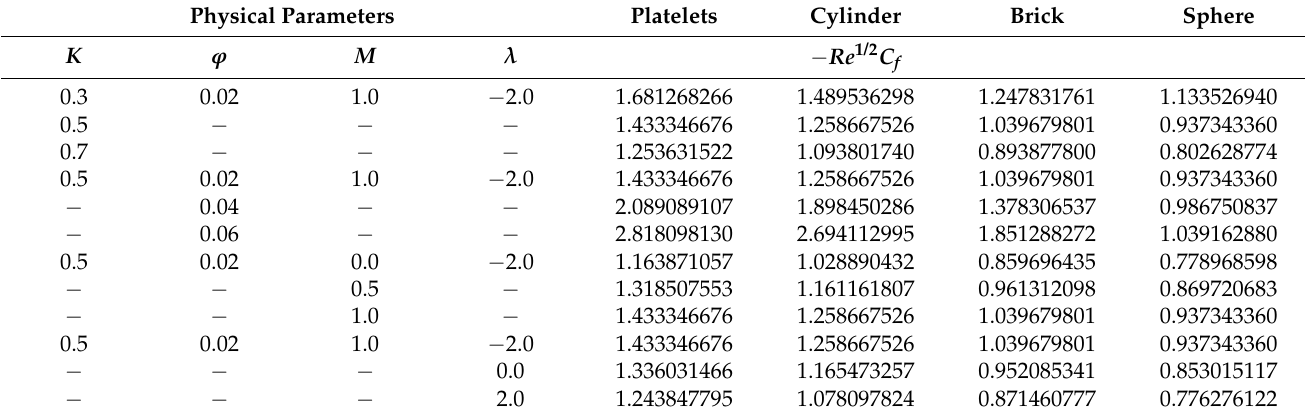
Table 4. Numerical values of skin-friction coefficient of multi-shape